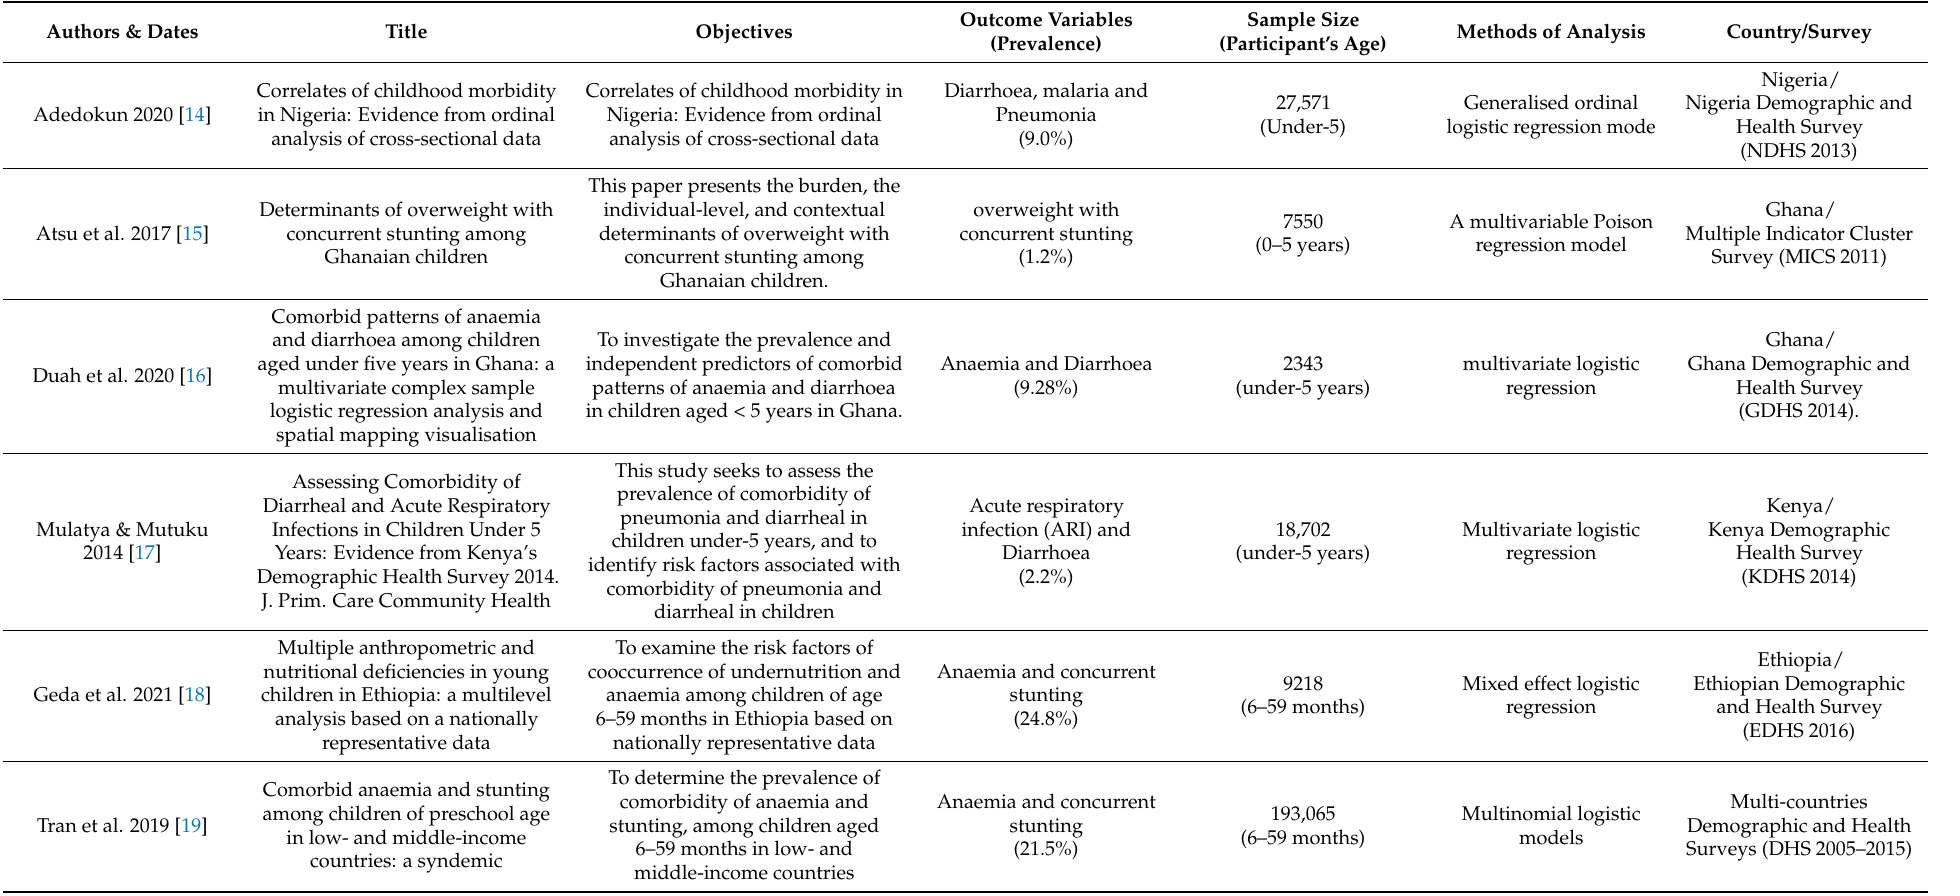
Table 2. Distribution of the study